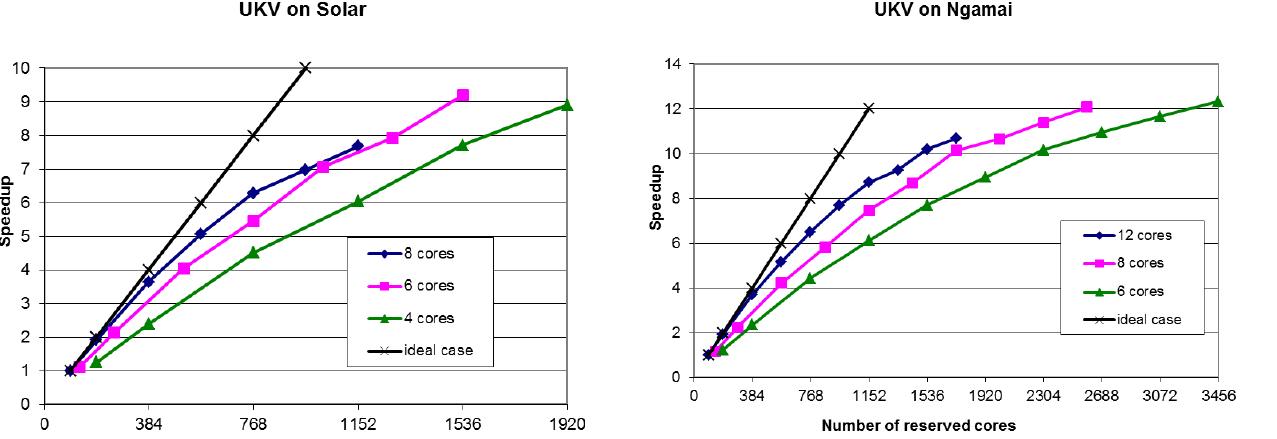
Figure 8. Speedup as a function of number of reserved cores on Ngamai. Speedup was calculated in relation to the elapsed time of 9608s obtained for a 96-core run on fully committed